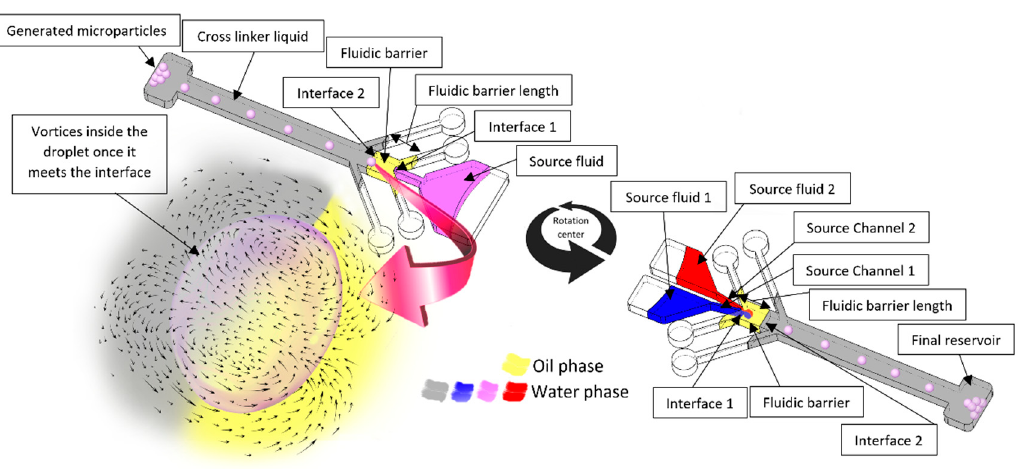
Figure 1. Schematic of centrifugal microfluidic device with one (on the left ) and two (on the right ) source fluids and different important parameters.